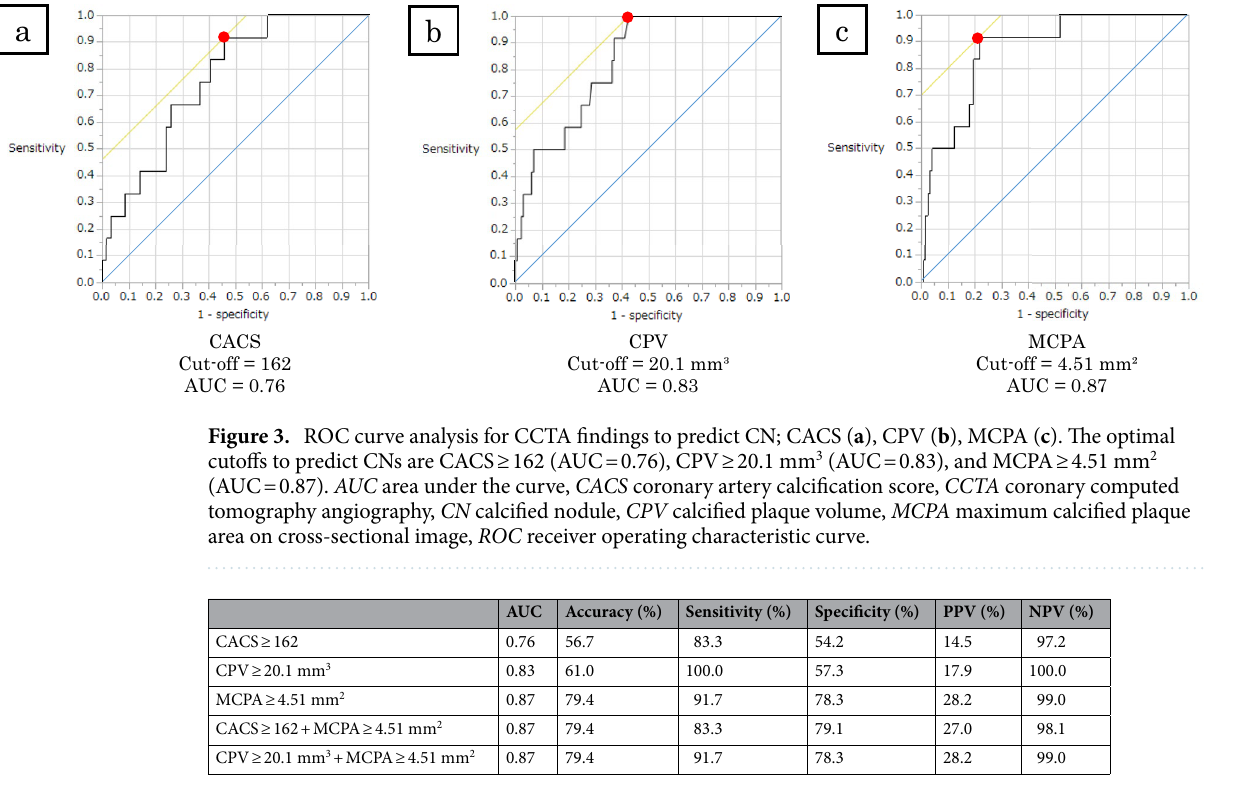
Table 4. Diagnostic accuracy of CCTA parameters for predicting OCT-detected CN. CACS coronary artery calcification score, CCTA coronary computed tomography angiography, CN calcified nodule, CPV calcified plaque volume, MCPA maximum calcified plaque area, NPV negative predictive value, PPV positive predictive value.